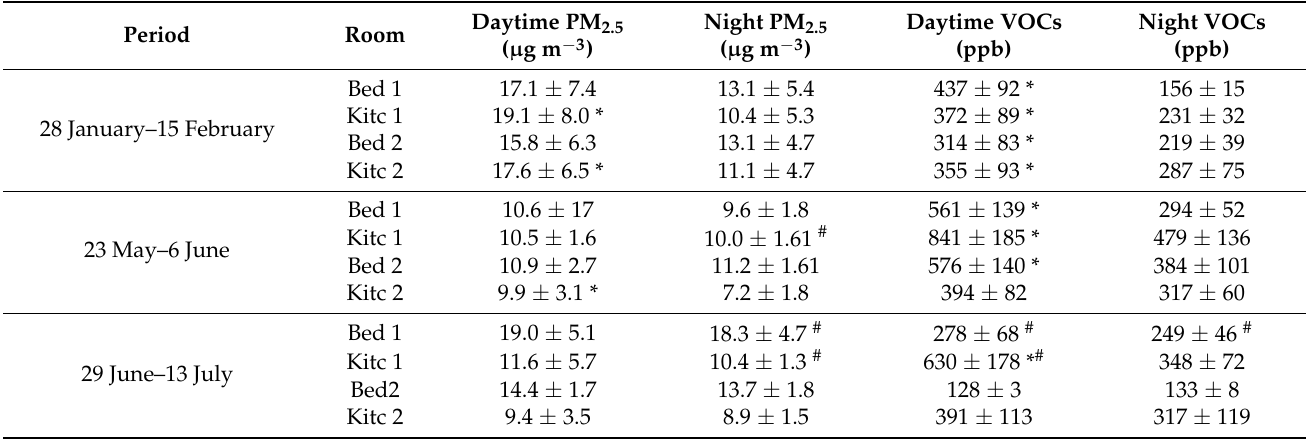
Table 3. Indoor PM 2.5 and VOCs concentrations measured during each monitoring campaign in each investigated room discriminated between daytime (from 9:00 a.m. to 9:00 p.m.) and night (from 9:00 p.m. to 9:00 a.m.) hours. Daytime PM 2.5 Night PM 2.5 Daytime Period Room ( µ g m − 3 ) ( µ g m − 3 )